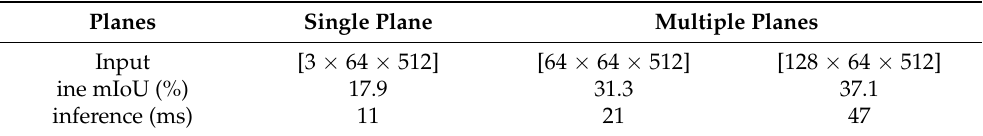
Table 3. Cylindric projection results. Even if the idea of using multiple planes brings a high improve- ment in performance, it is not comparable with the other proposed